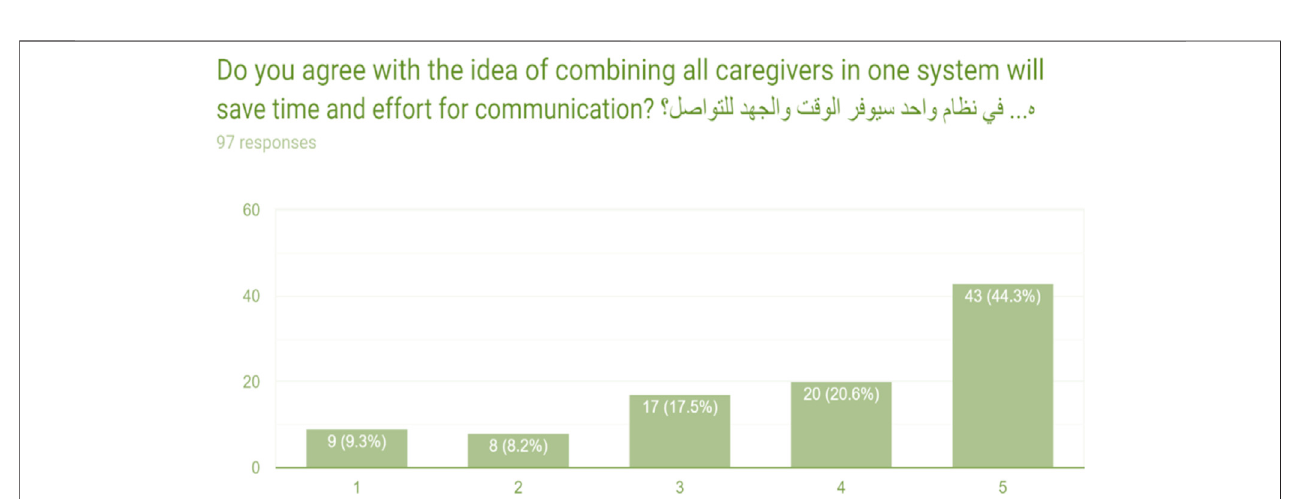
FIGURE 5 | Caregiver ’ s questionnaire